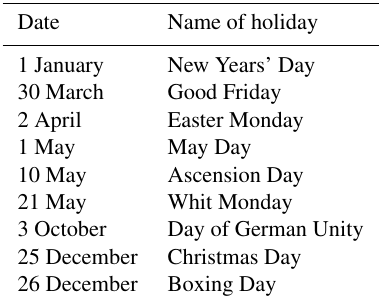
Table 2. Official holidays in Germany, 2018.